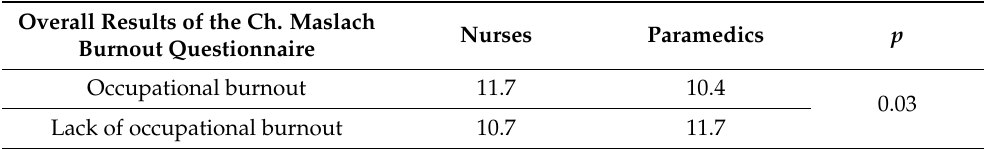
Table 8. The correlation between the occurrence of occupational burnout and the occupation of the study